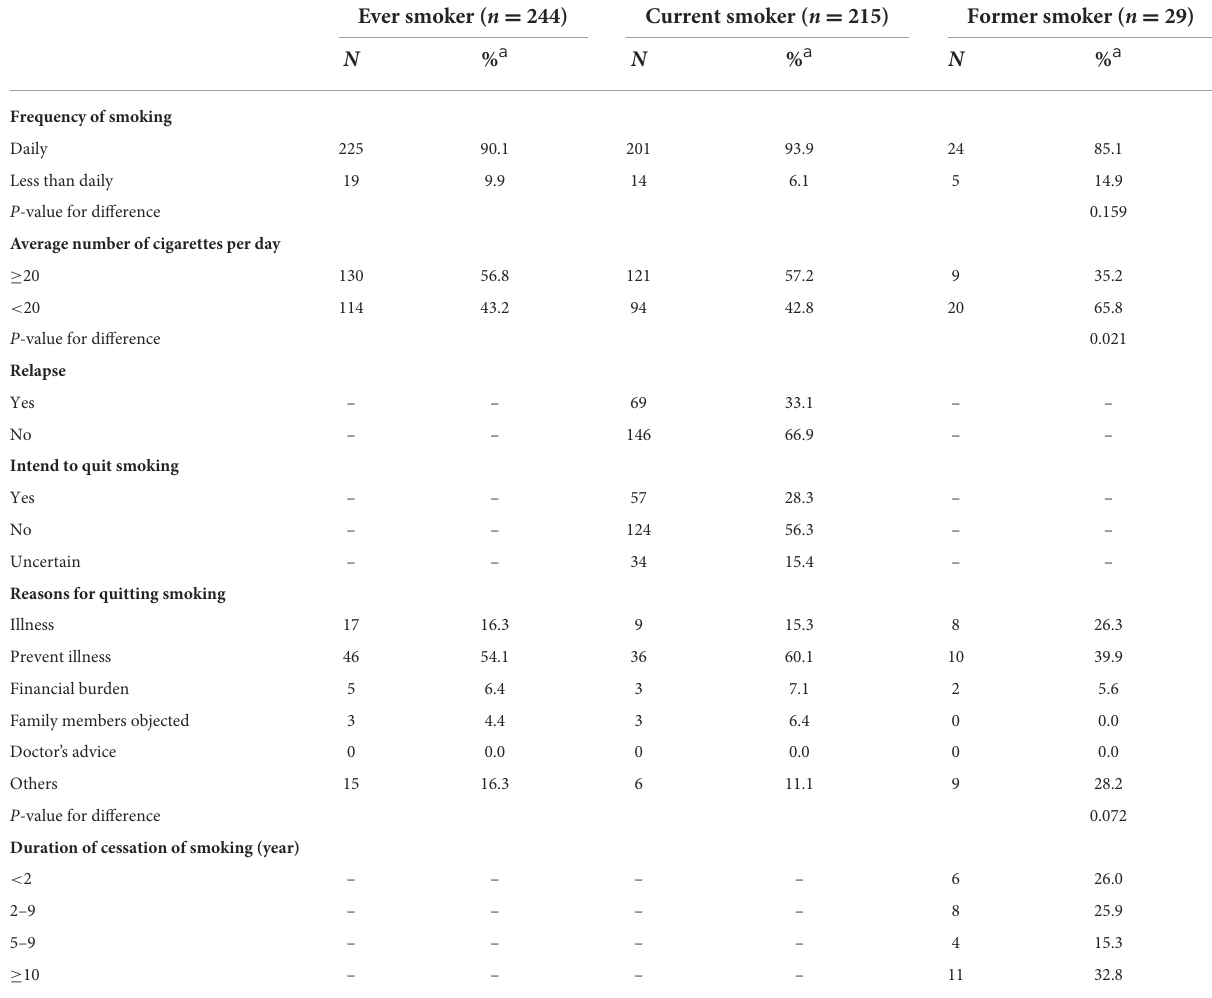
TABLE 3 Smoking patterns of the participants, stratified by smoking